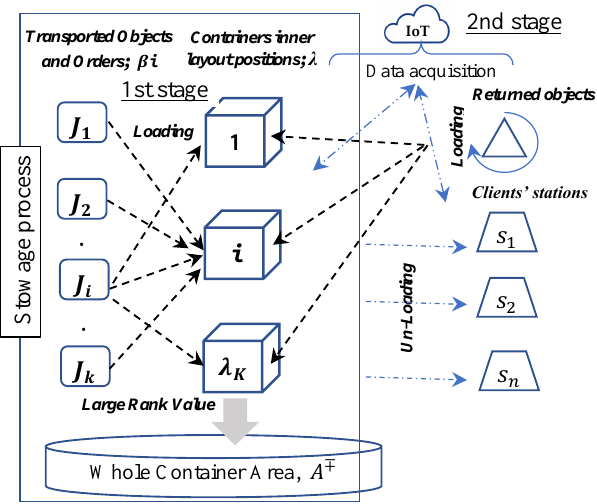
Figure 1. The main relationships in the distribution chain need stowage.